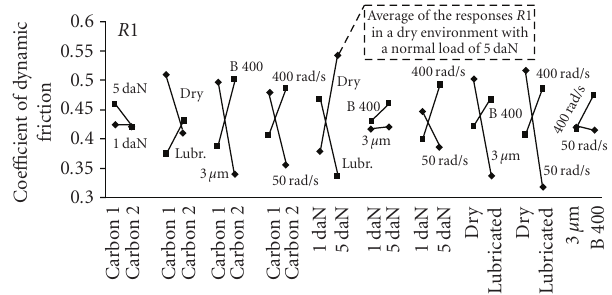
Figure 4: Interaction e ff ects on the coe ffi cient of dynamic friction ( R